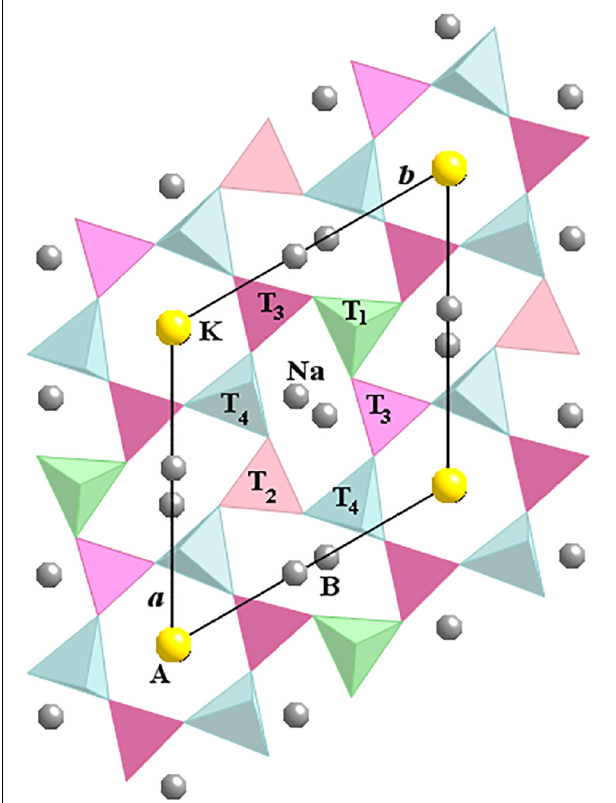
FIGURE 1 | Crystal structure of nepheline projected down the c axis. A is the hexagonal site that contains K atoms and vacancies, and B is the oval-shaped site that contains mostly Na atoms that may be substituted by Ca and K atoms. The T 2 and T 3 tetrahedra have apices pointing downwards, whereas T 1 and T 4 tetrahedra point upwards. The Al and Si atoms are highly ordered in the T sites for most nepheline samples.